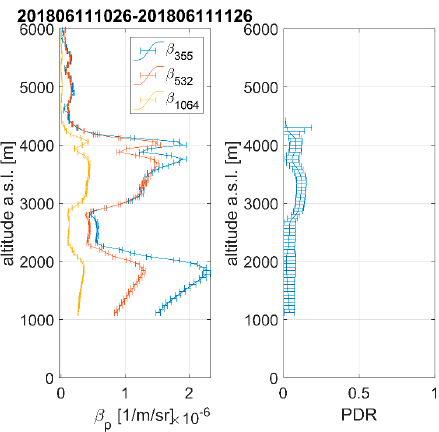
Figure 13. Lidar measurements around 12 UTC: particles backscatter coefficient for 355, 532, and 1064 nm ( left ) and particle linear depolarization ratio at 532 nm ( right ).